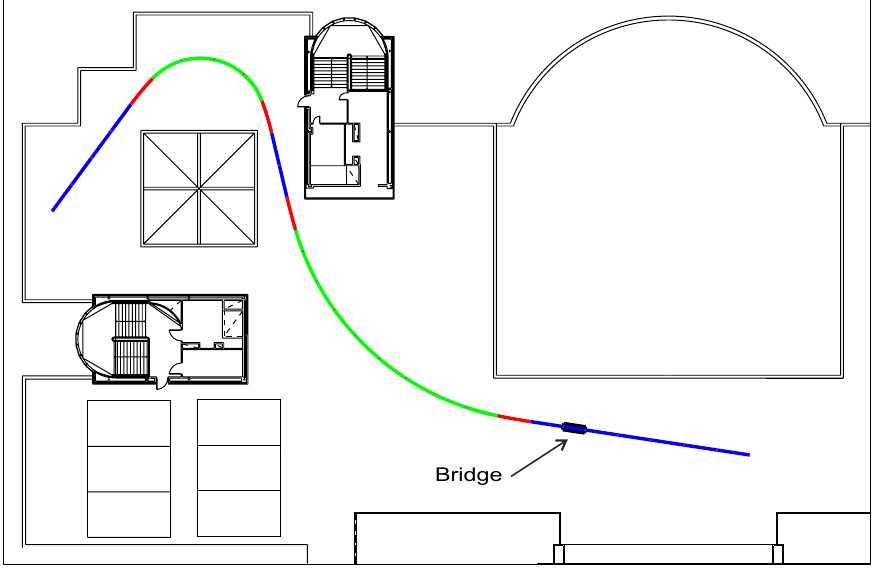
Figure 1. Track horizontal projection. In blue are the 3 straight sections; in red are the 4 transition sections and in green the 2 constant curvature sections. A bridge is located in a straight